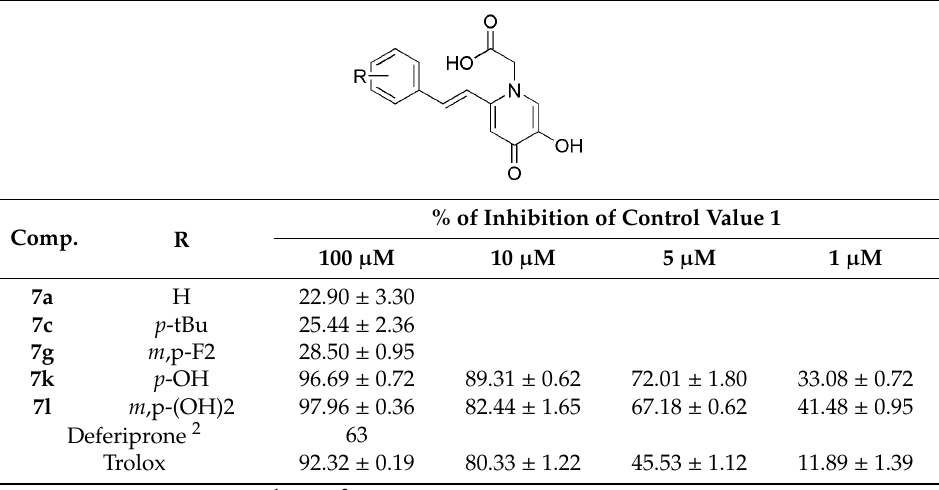
Table 1. Enzyme inhibition activity of 5-hydroxy-4-oxo-2-styryl-4H-pyridinone derivatives. Table 2. DPPH radical scavenging activity of 5-hydroxy-4-oxo-2-styryl-4 H -pyridinone derivatives.